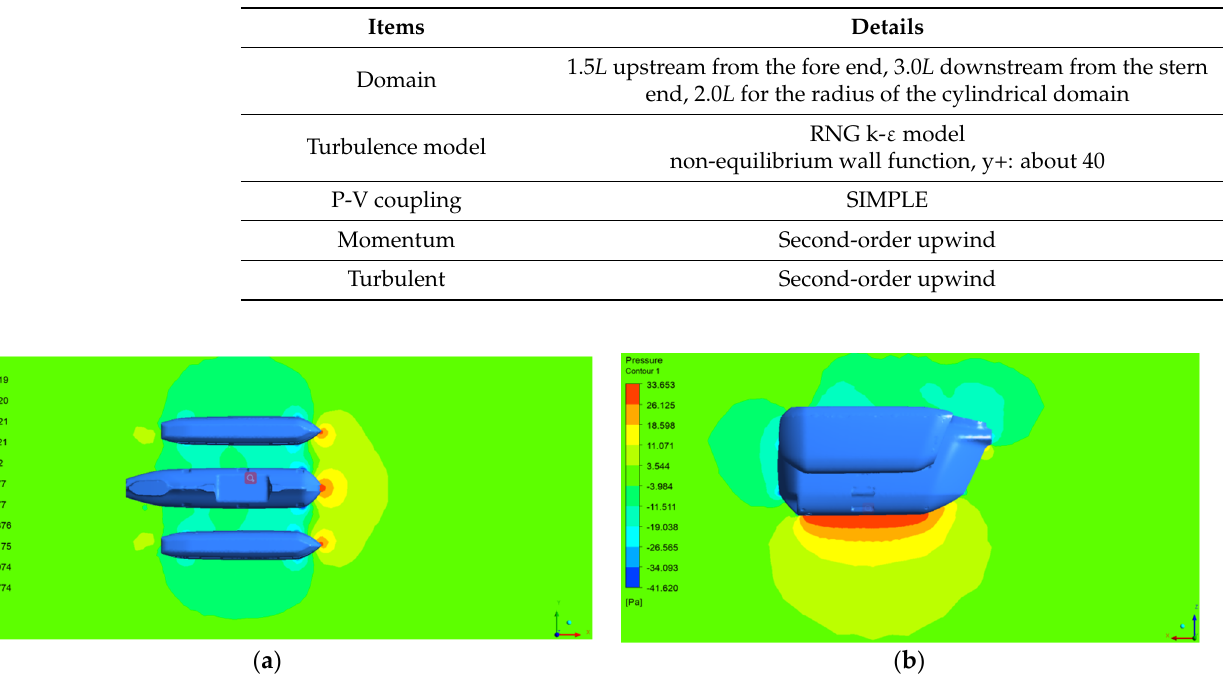
Figure 10. The computational domain. Table 5. A summary of the numerical analysis settings.